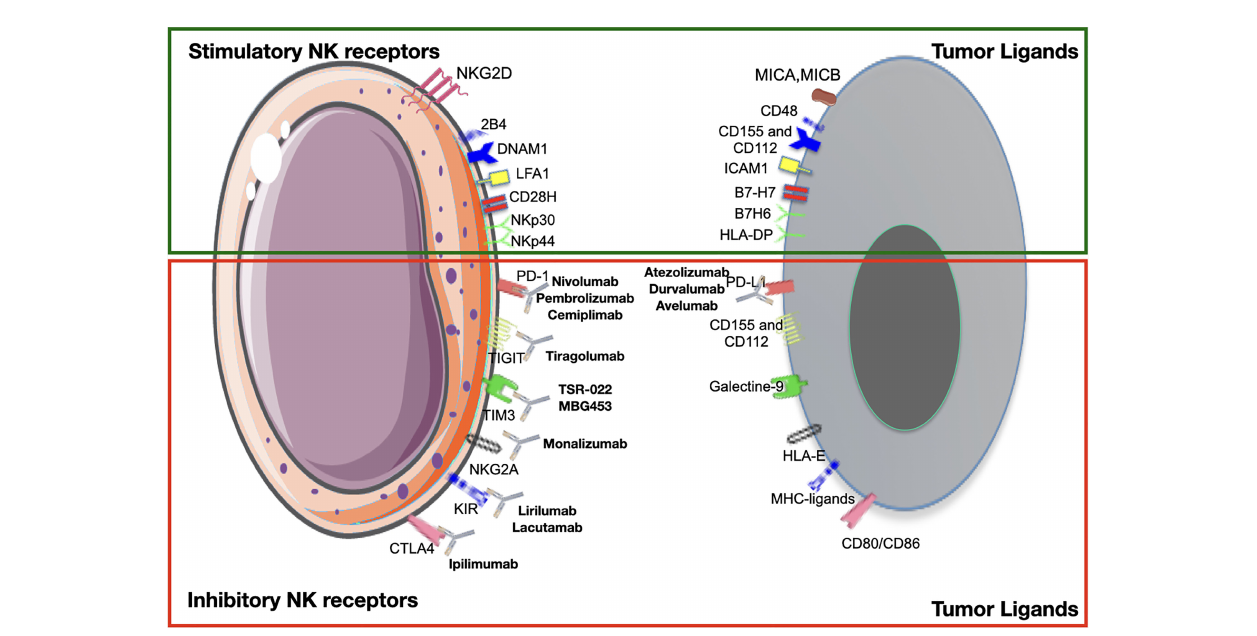
FIGURE 4 | Activating and inhibitory receptors on natural killer cells (NKs) and their ligands on tumor cells. Checkpoint inhibitors bind to inhibitory receptors on NKs, preventing the link with their ligands on tumor cells and vice versa. Here are reported the major pathways and monoclonal antibodies currently used in clinical practice or under evaluation in clinical trials.